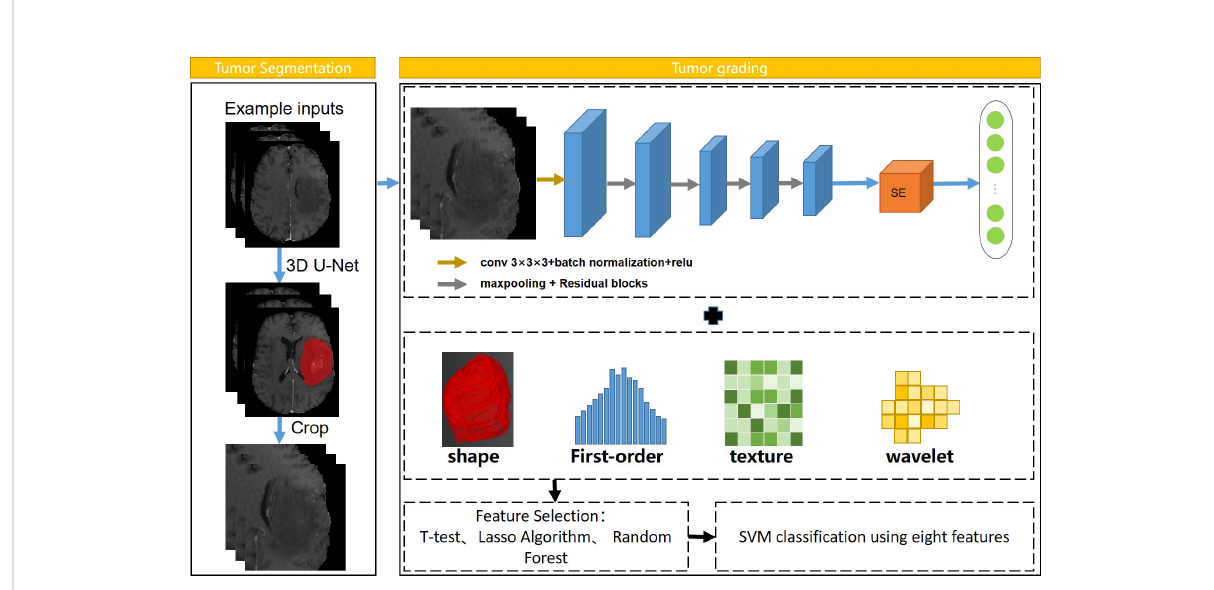
FIGURE 1 Work fl ow of automatic tumor grading. Resnet18 was used to extract CNN features, and SVM was selected as the classi fi